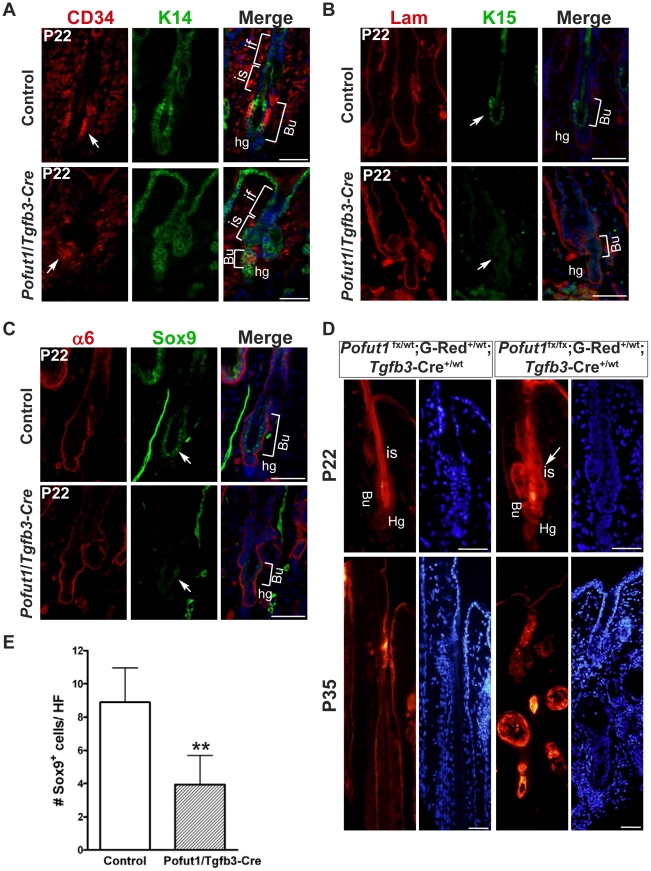

Pofut1 deletion in hair follicle lineages has an impact on bulge stem cells.(A) Back skin samples from control and Pofut1/Tgfb3-Cre mice at P22 were double-stained for K14 and CD34. is: isthmus. if: infundibulum. Bu: bulge, hg: hair germ. (B, C) Back skin samples from control and Pofut1/Tgfb3-Cre mice were double-stained for K15 and laminin (K15/Lam) (B), and Sox9 and α6-integrin (Sox9/α6) (C). Images from individual staining are shown in separate panels and superimposed images are displayed in the corresponding right panel (Merge). Immunostaining for laminin or α6-integrin was used to confirm a proper orientation of the follicle in sections and misangled follicles were excluded from analyses. (D) Back skin samples from Pofut1
fx/wt;G-Red+/wt;Tgfb3-Cre+/wt and Pofut1
fx/fx;G-Red+/wt;Tgfb3-Cre+/wt mice at P22 and P35 were sectioned and examined by fluorescence microscope. DsRed-positive (Red) and DAPI-counterstained (blue) signals were shown. arrow: isthmus hyperplasia. (E) Quantification of Sox9-positive (Sox9+) cells in the bulge region from control and Pofut1/Tgfb3-Cre mice at P22. A bar diagram shows the number of Sox9+ cells per hair follicle (mean+/−s.d., n = 80) from two independent control and mutant pairs, **:P<0.01. Antibodies used are color-coded according to fluorophore-tagged secondary antibodies. DAPI counterstaining in blue. Scale bar, 50 µM.